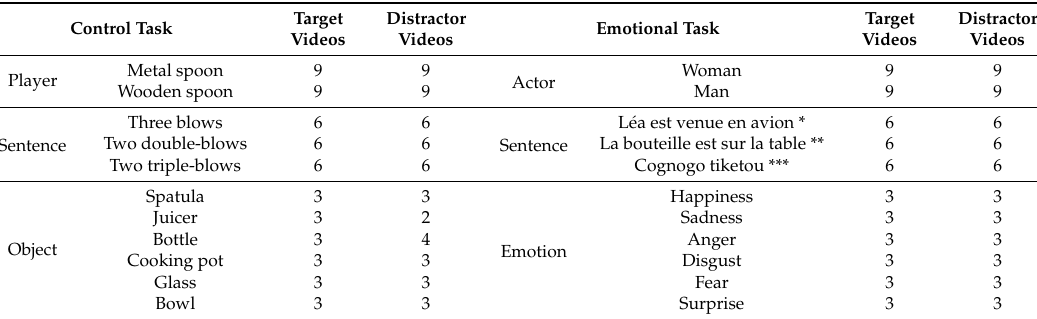
Table 2. Number of appearance of the key elements contained in the video